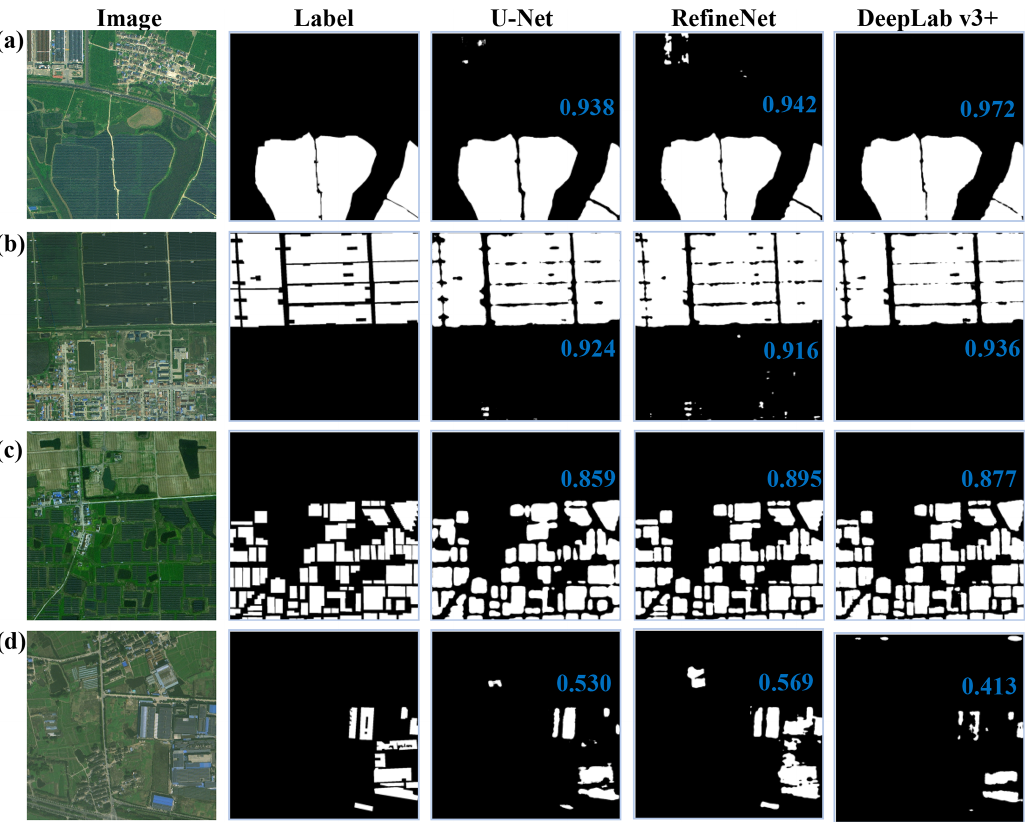
Figure 4. Segmentation results of PVs in PV08 dataset. We show examples of concentrated ground PVs (a, b) , distributed ground PVs (c) , and distributed rooftop PVs (d) . IoU of each segmentation result is marked in blue within the